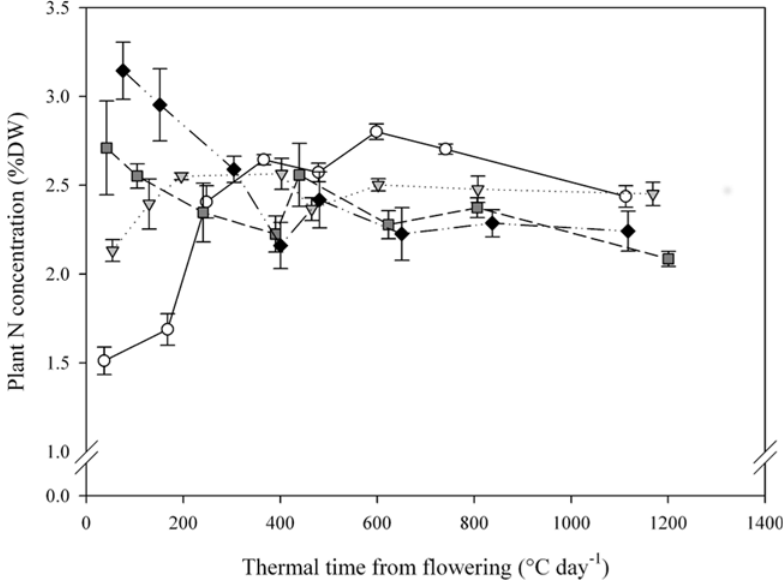
Fig 1. Plant N concentration dynamics during the post-flowering period for the four NO 3- treatments. Values are the means of four biological repetitions ± 1 standard error for N1 (open circles), N4 (grey triangles), N7 (dark grey squares) and N10 (black